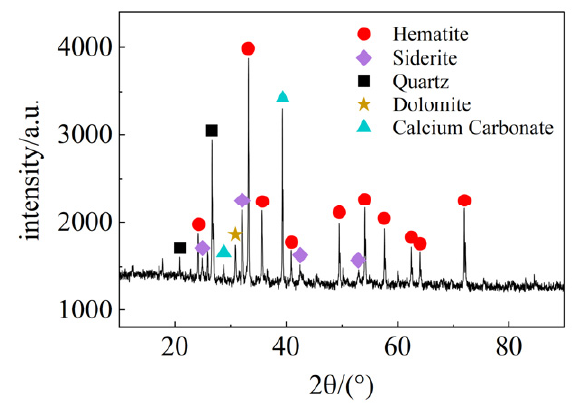
Figure 3. X-ray diffraction analysis of specularite.